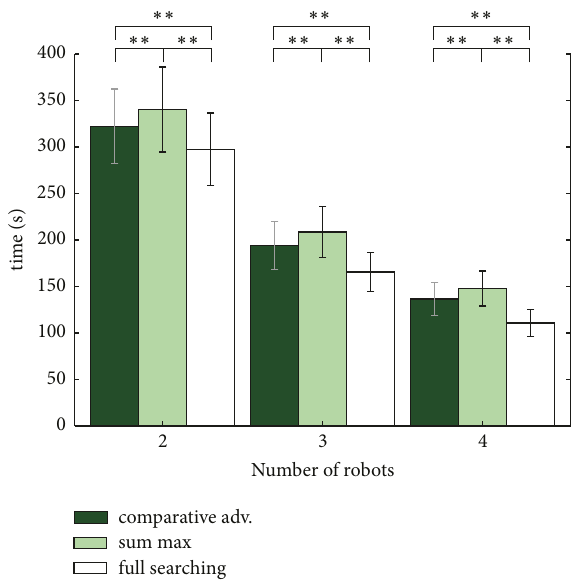
Figure21:Makespanofsomenumberofrobots. ∗∗ 𝑝 < .01 , ∗ 𝑝 < .05 , and + 𝑝 < .1 . A significant 𝑝 value indicates that a significant difference in prescribing exists between the conditions. The lower 𝑝 value indicates a strong significant difference. n.s. means no significant difference between the conditions.